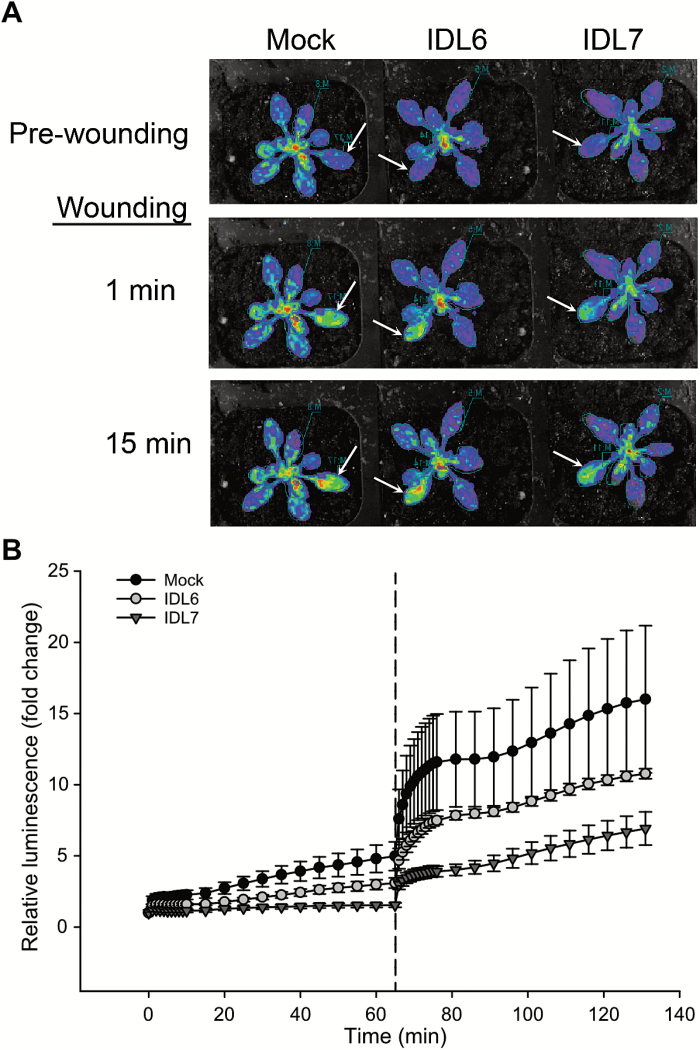
Suppression of the rapid wound-induced signal in ZAT12::luc plants by IDL6-EPIP and IDL7-EPIP peptides. Plants pre-treated with IDL6-EPIP, IDL7-EPIP, or MOCKIDL7 (100 nM) by spraying were simultaneously wounded in one leaf (marked with arrows), and changes in luminescence were immediately measured using the NightOwl in vivo imaging system. (A) Representative pictures are shown. Injured leaves are marked with arrows. (B) Quantification of the wound-induced signals in rosette leaves over the time course before and after wounding. Error bars indicate the SD between three biological replicates. (This figure is available in color at JXB online.)